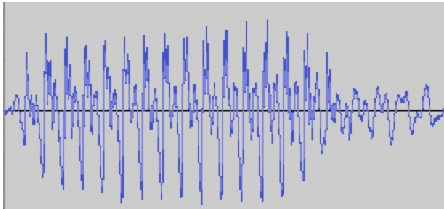
Figure 3. Waveform of spoken digit zero.